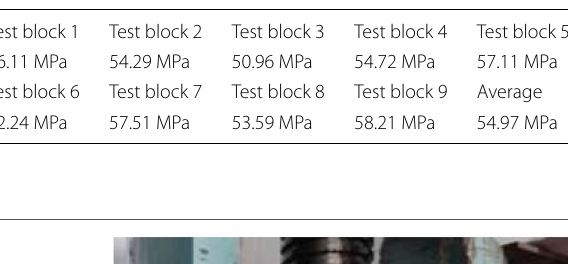
Table 2 Compressive strength of concrete cube.